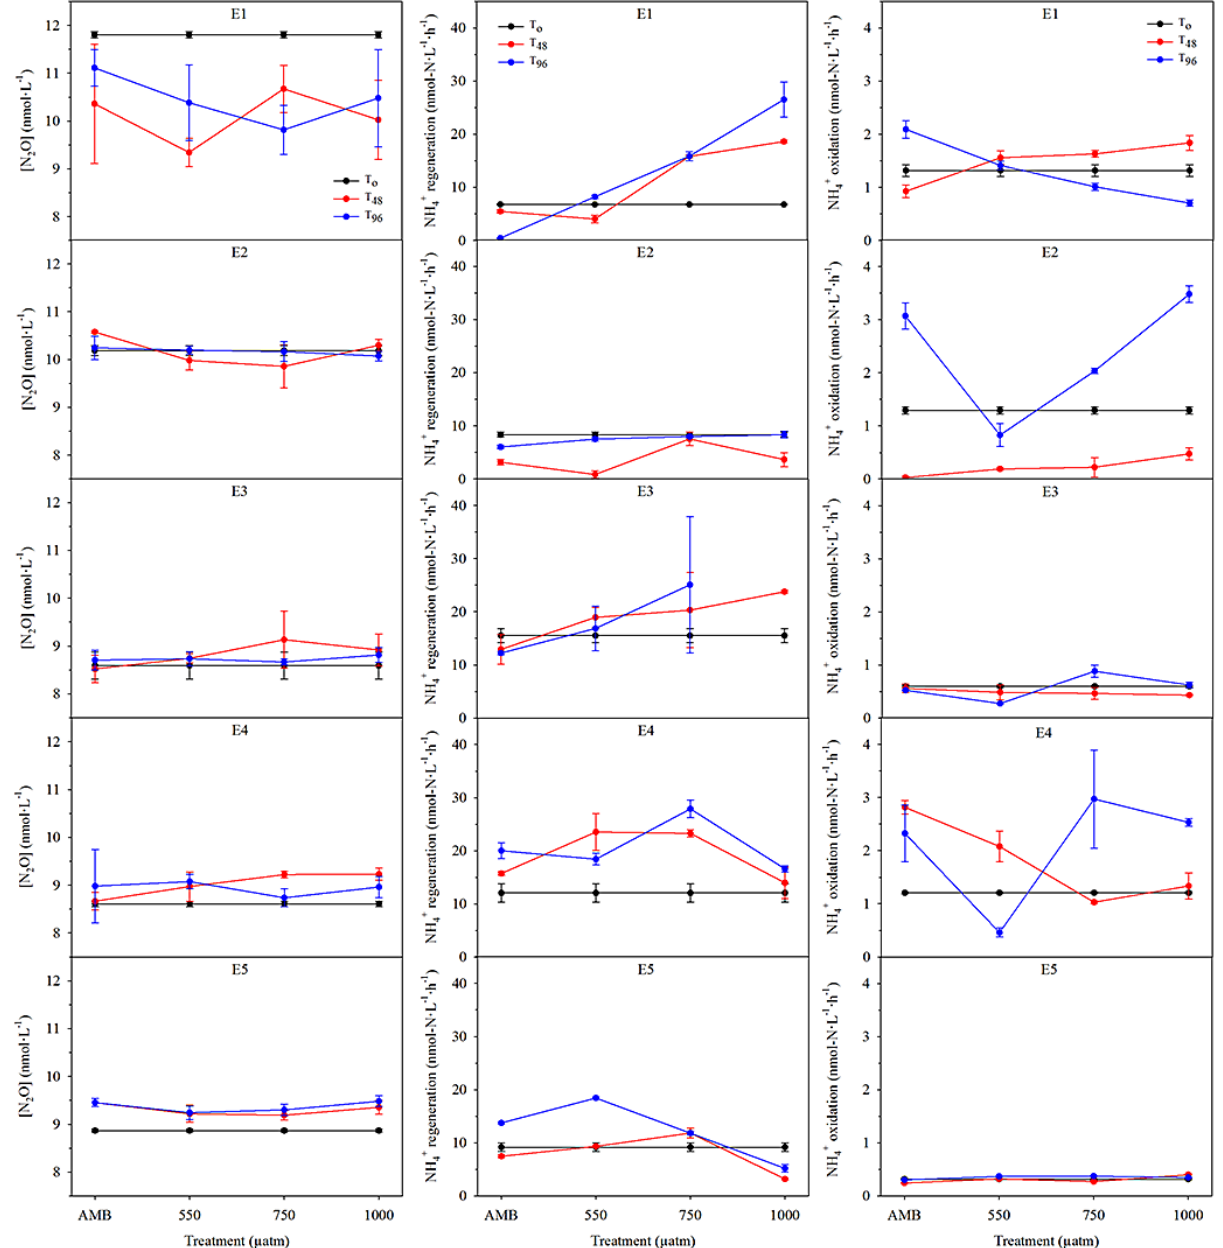
Figure 9. Bioassay data for changes in N 2 O concentration, NH + Note that T 0 values were only measured in ambient treatments. Values are copied over to 550, 750 and 1000 µatm P CO 2 treatments to aid comparisons. Treatment labels represent the initial intended P CO 2